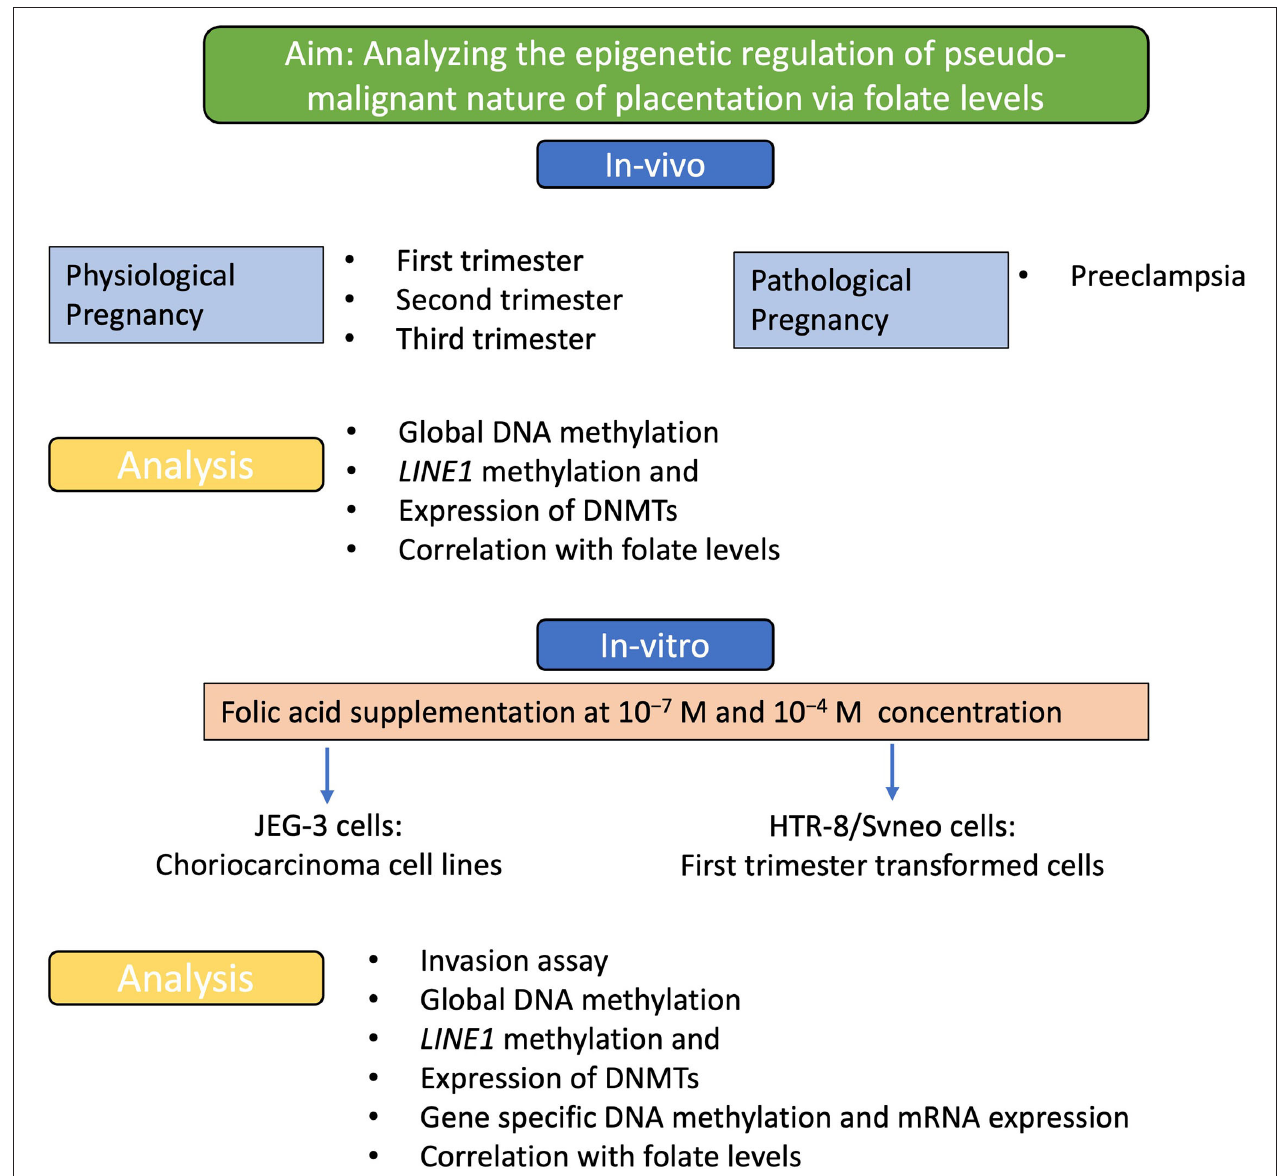
FIGURE 1 | Experimental strategy. A flow diagram to show the aim of the study and the experimental strategies used to achieve this aim. Analyzing the effect of folic acid levels in-vivo and the effect of folic acid supplementation in-vitro , to understand the effect on the pseudo-malignant phenotype at the molecular and epigenetic